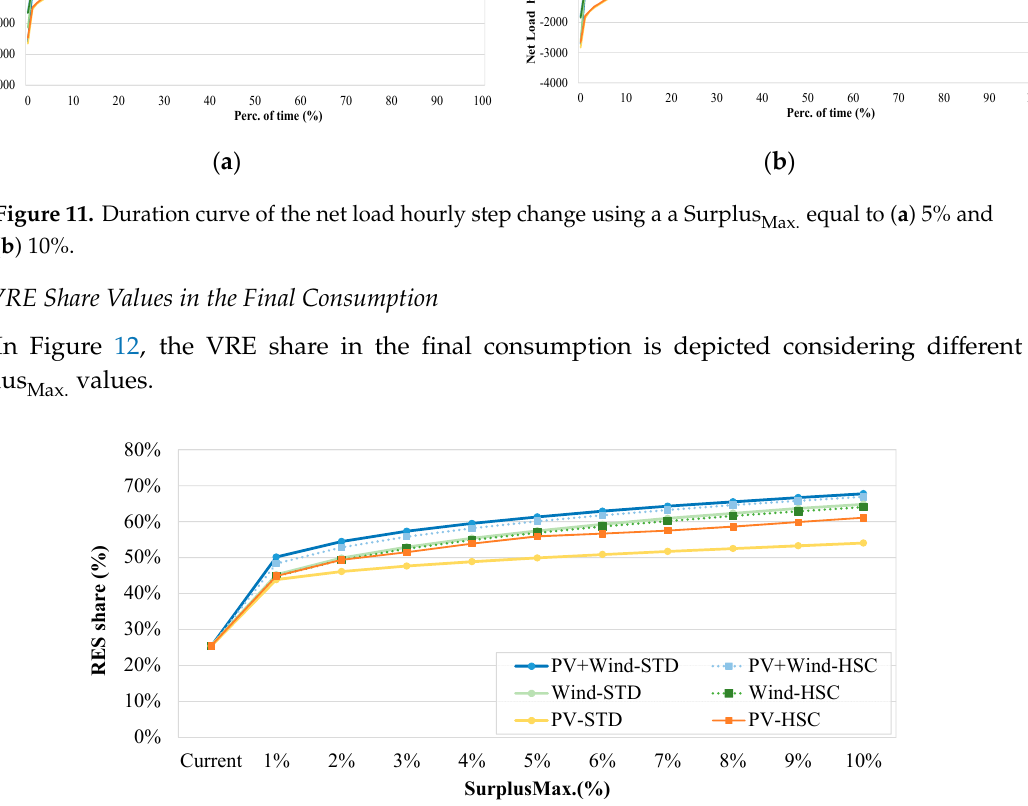
Figure 11. Duration curve of the net load hourly step change using a Surplus (cid:2923)(cid:2911)(cid:2934). equal to ( a ) 5% and ( b ) 10%.